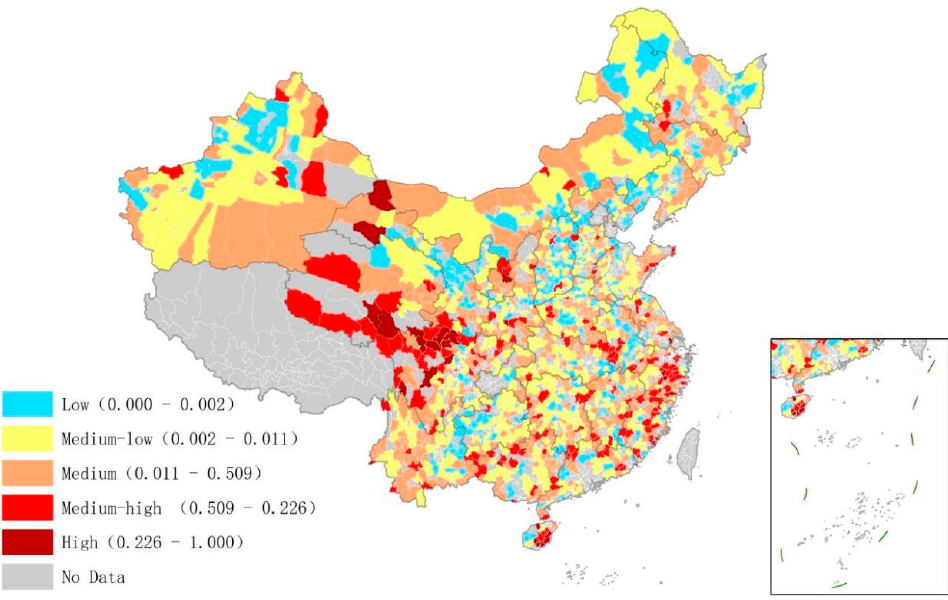
Figure 1. Low-carbon management efficiency of the industrial sector in Chinese counties.